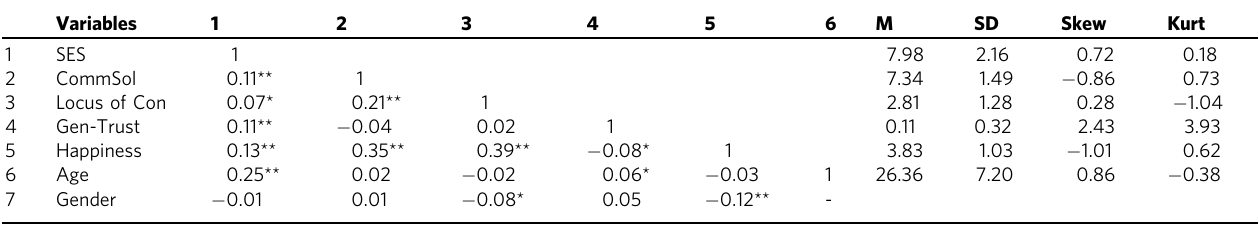
Table 2 Means, standard deviations and correlations between study variables ( N = 1000).